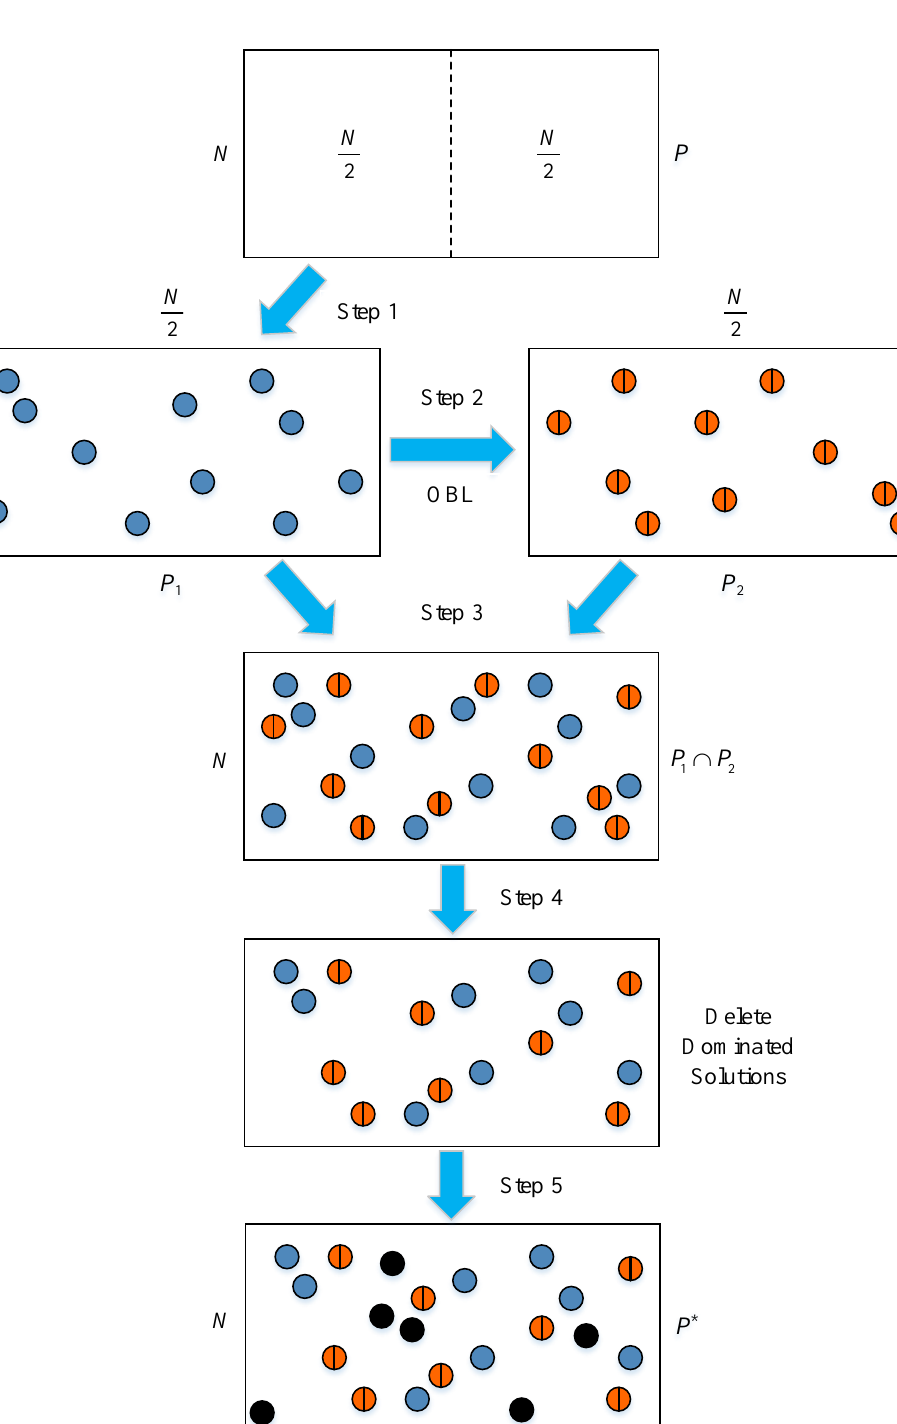
Figure 2. Initialization based on OBL.